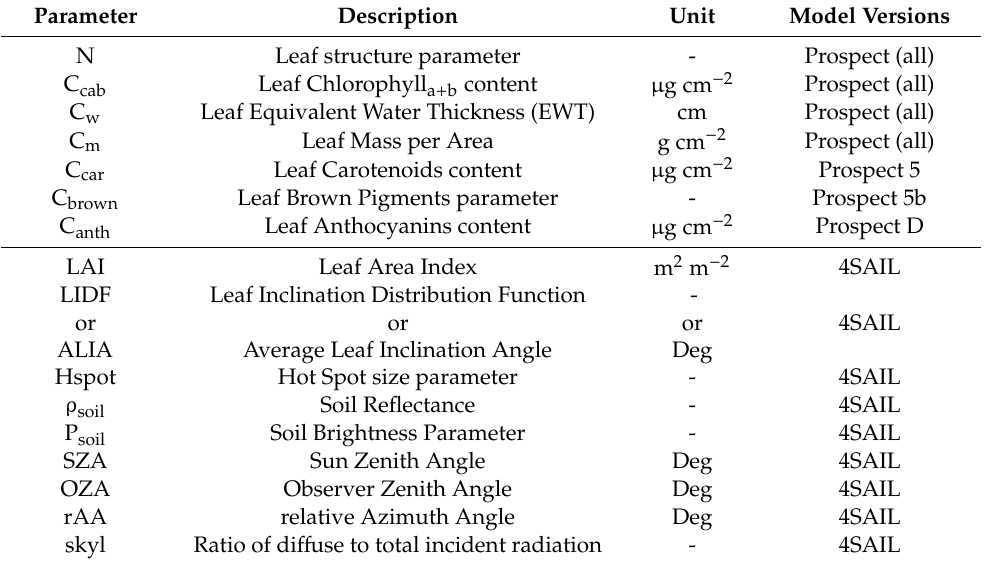
Table 1. Overview of the PROSAIL parameters and their according dimensions. Some parameters, for example, the leaf chlorophyll content, are used in all PROSPECT versions, whereas other parameters were included in newer